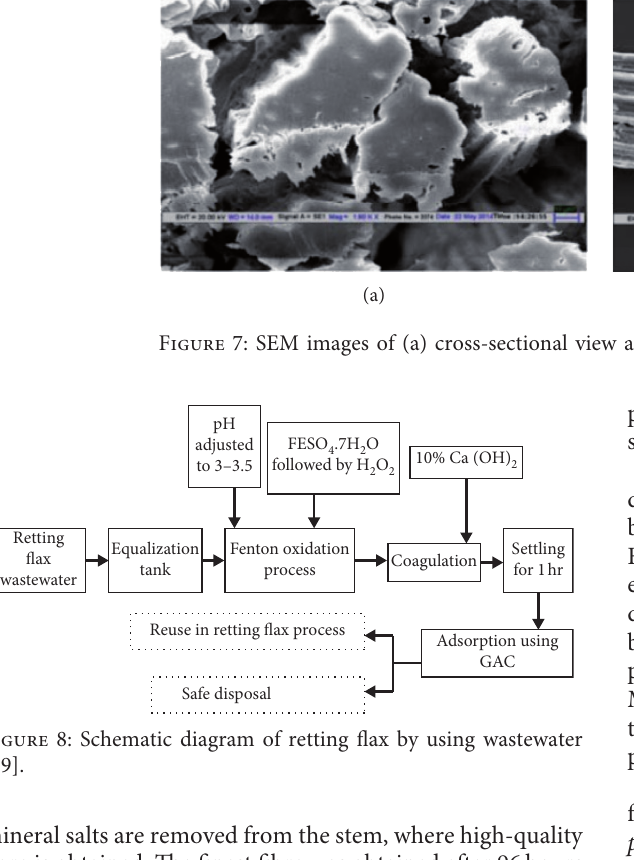
Figure 8: Schematic diagram of retting flax by using wastewater